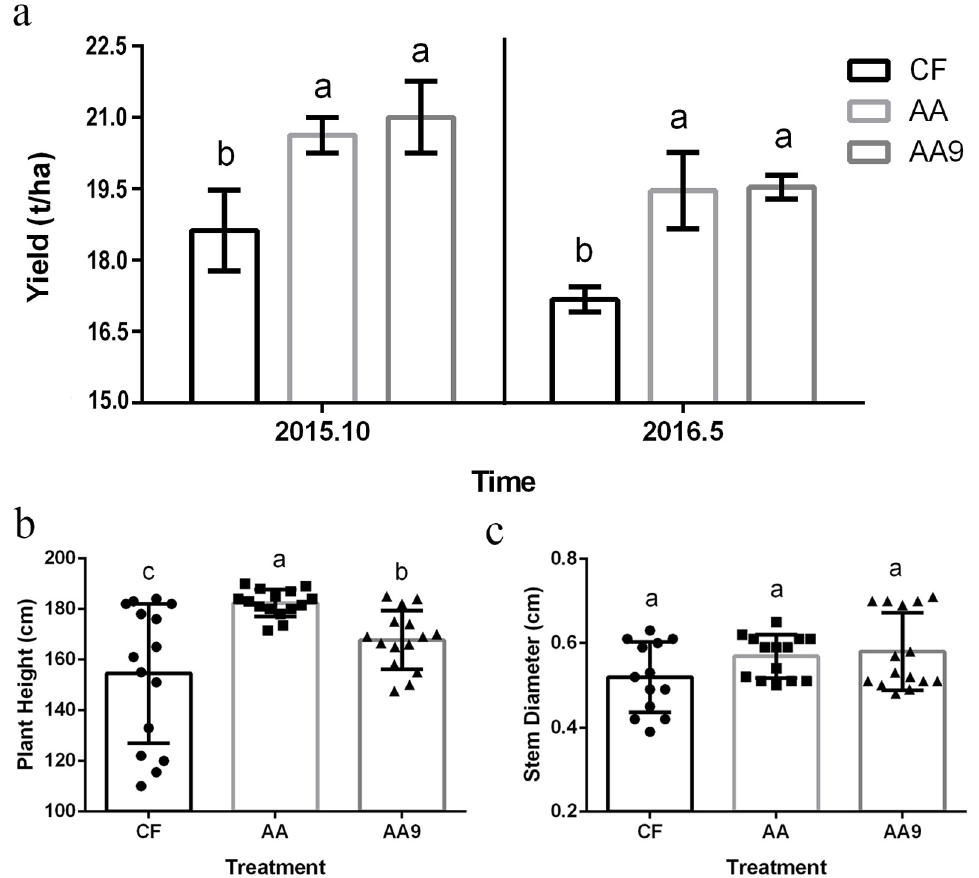
Fig 1. Effects of spraying different fertilizers on cowpea biomass. Effects of spraying different fertilizers on cowpea yields (a; Mean ± SD, n = 3) and plant height (b; Mean ± SD, n = 15) over two seasons, and stem diameter (c; Mean ± SD, n = 15) in the first season. CF, treatment sprayed with chemical fertilizer; AA, treatment sprayed with amino acids liquid fertilizer; AA9, treatment sprayed with liquid biological fertilizer. Different letters in the same line indicate significant differences as defined by Duncan’s test ( P <